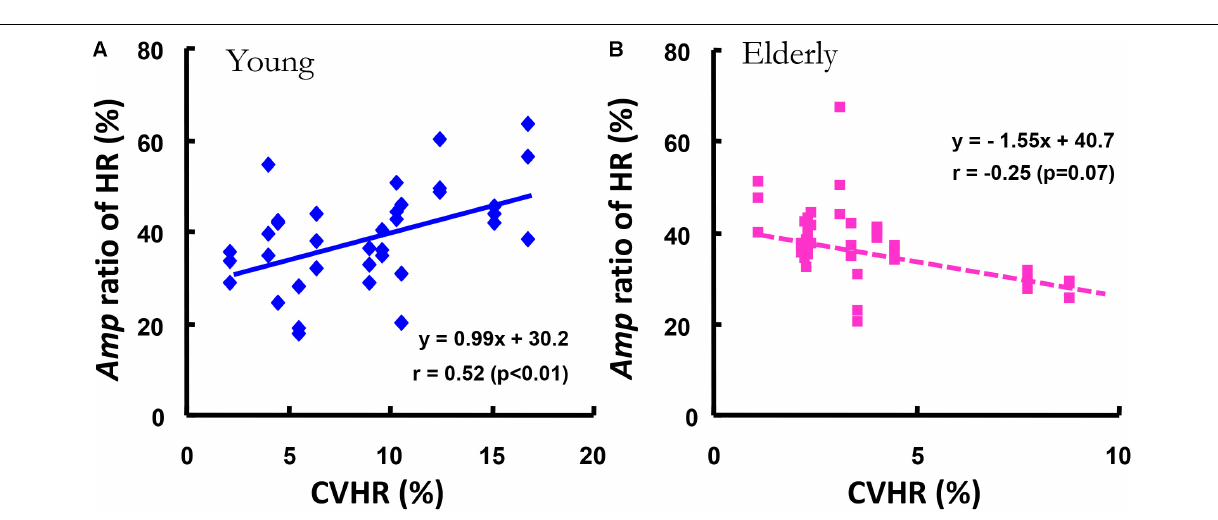
in the ELD a significant relationship was not found ( r = −